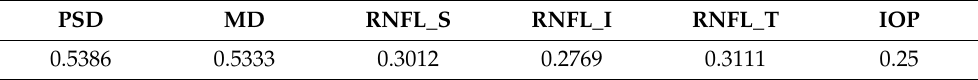
Table 8. Results of the min–max normalization for the target examination data.